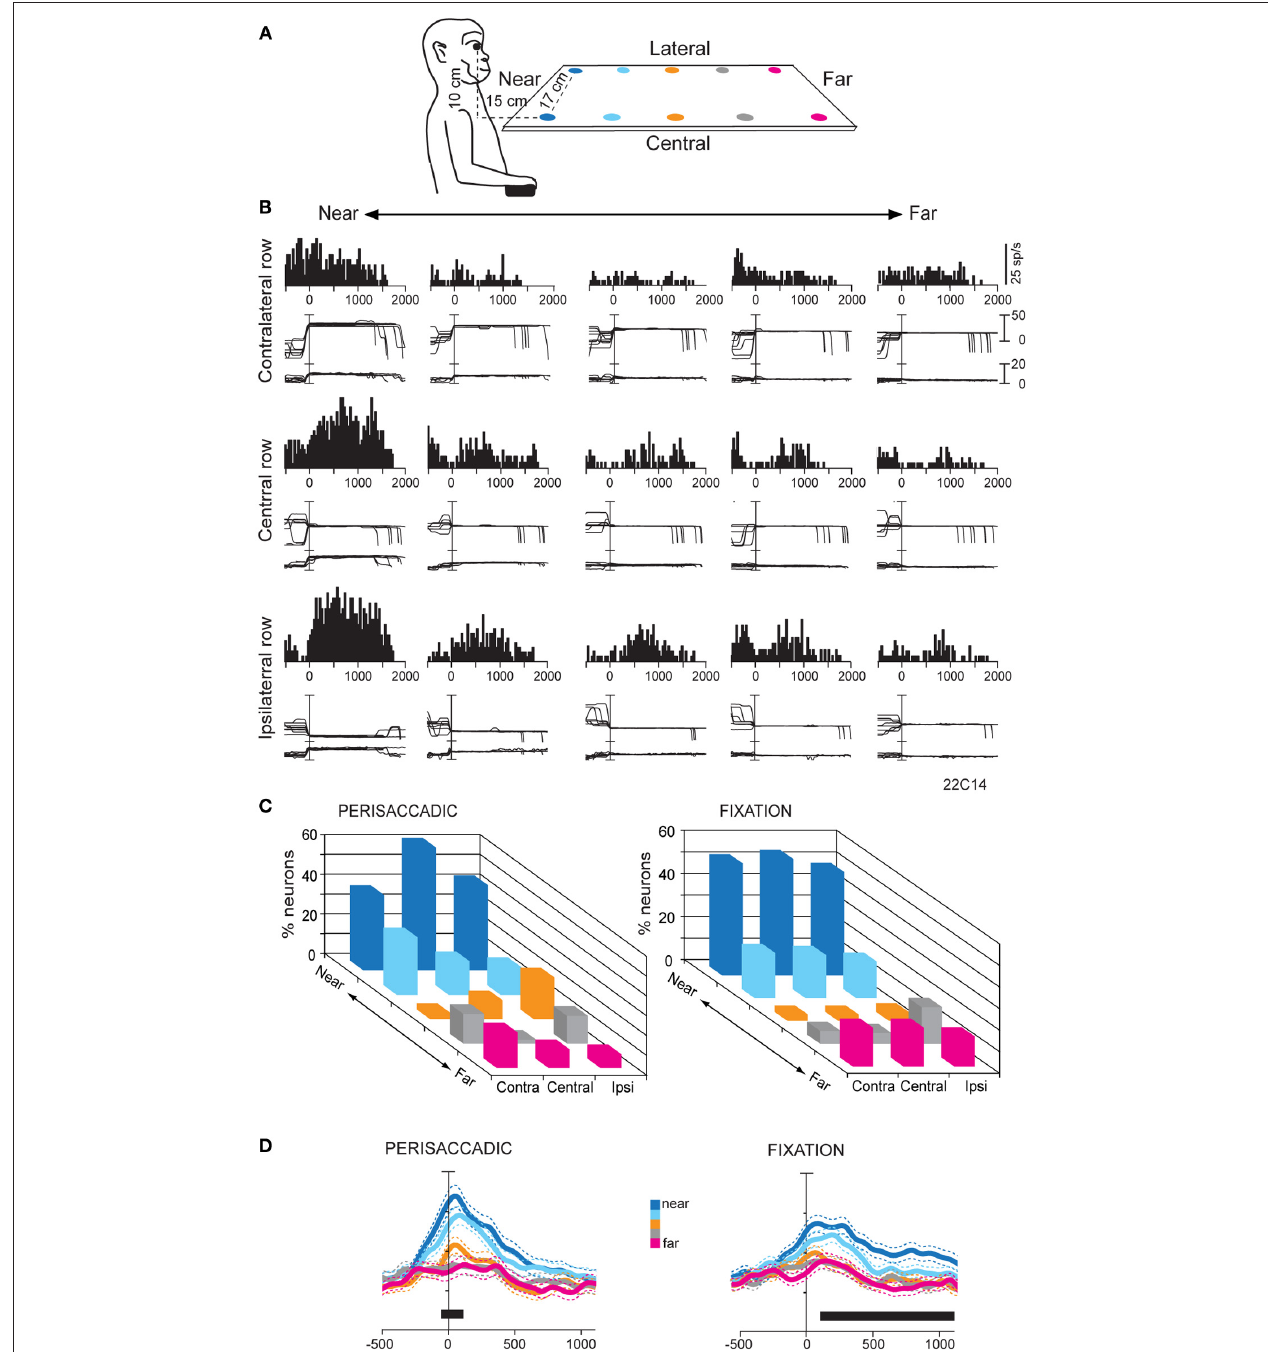
FIGURE 4 | (A) Scheme of the set up used for the fixation-in-depth task below eye level. The monkey was fixating in darkness one of the LEDs embedded in each panel. The LEDs are depicted with different colors according to their distance from a frontal plane passing from monkey’s eyes. (B) Example of a V6A neuron modulated by vergence during fixation below eye level. Top/Middle/Bottom: neural responses (peristimulus time histograms) and eye traces to the five LEDs of the contralateral/central/ipsilateral space arranged from near (left) to far (right), aligned at the end of the saccade. This cell prefers targets located at near and ipsilateral space. Other conventions as in Figure 3 . (C) Frequency